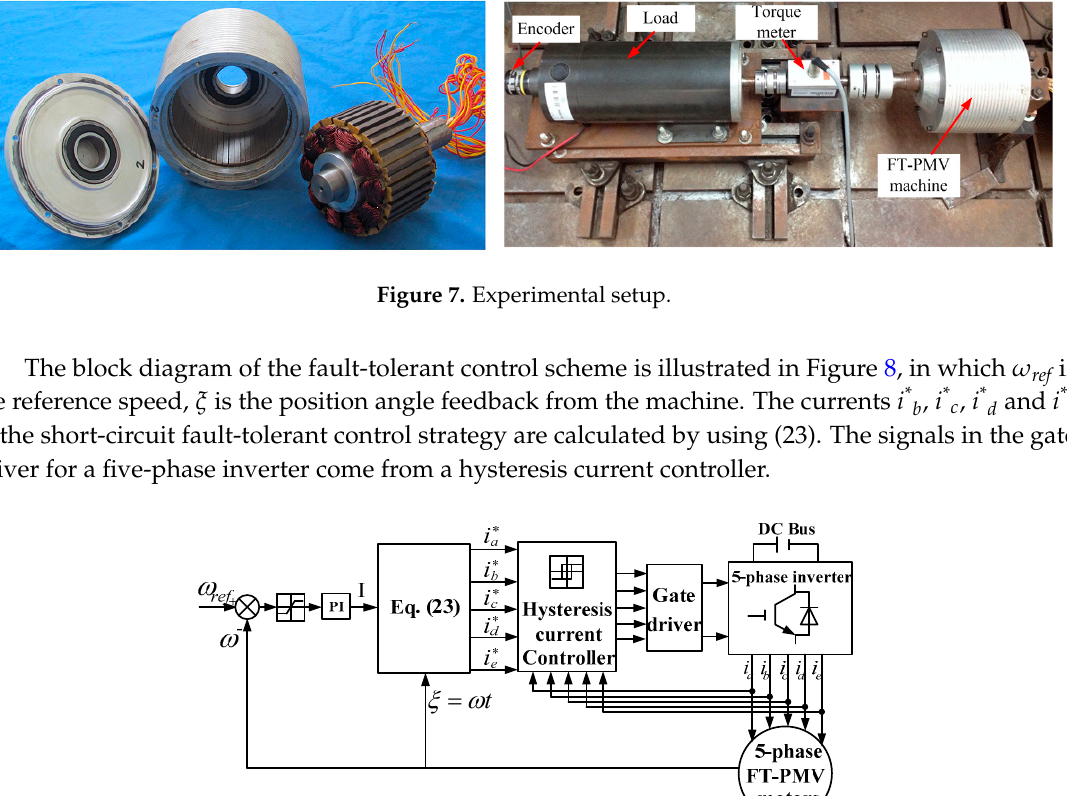
Figure 8. Block diagram of proposed fault ‐ tolerant control scheme.